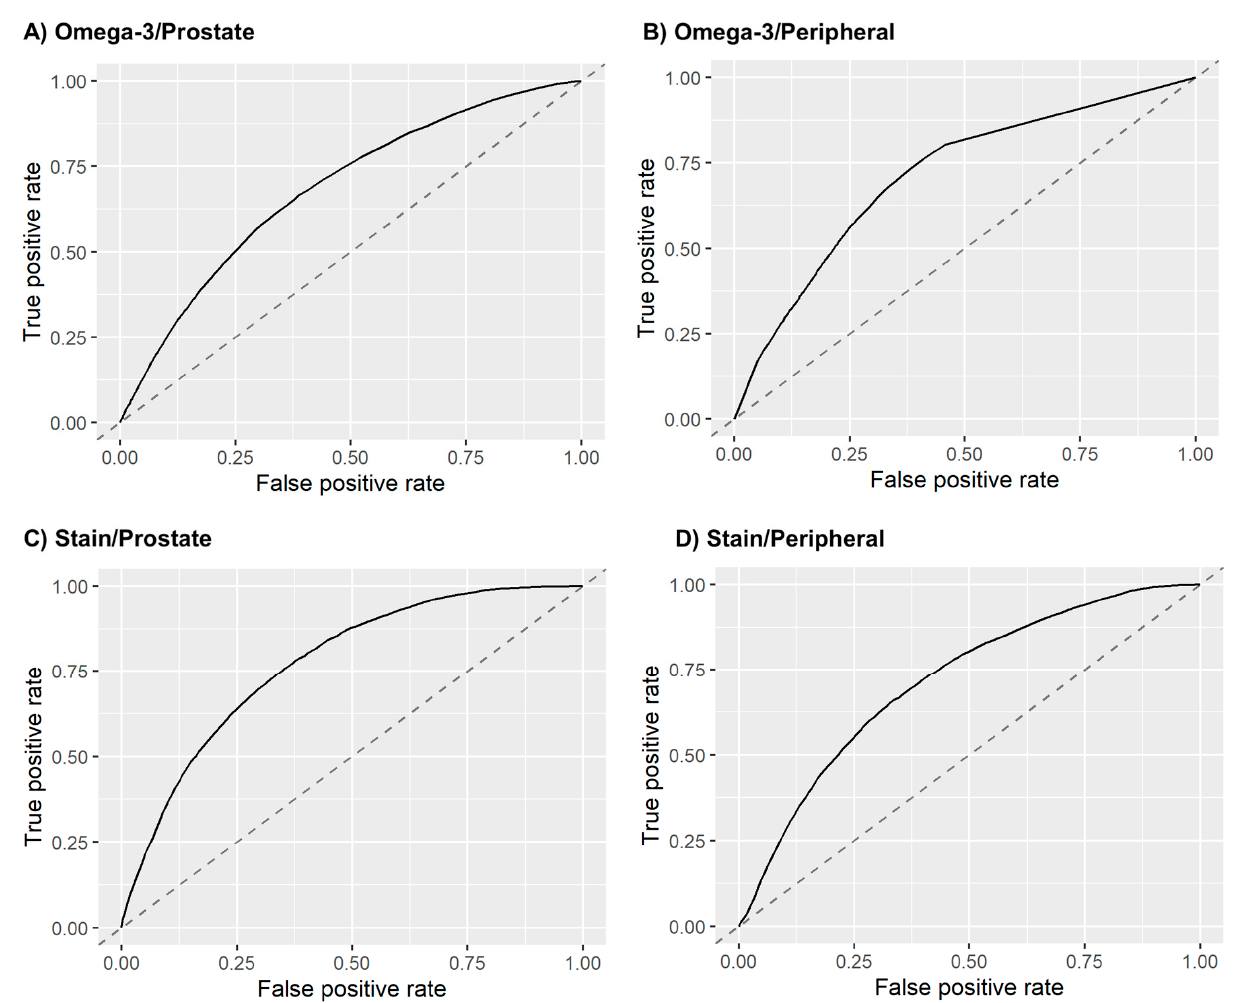
Figure 4. Average ROC curves of the radiomics model for ( A ) omega-3 usage prediction based on prostate ROI, ( B ) omega-3 usage prediction based on peripheral ROI, ( C ) statin usage prediction based on prostate ROI, and ( D ) statin usage prediction based on peripheral ROI. The ROC curves are averaged from the 1500 validation test sets.